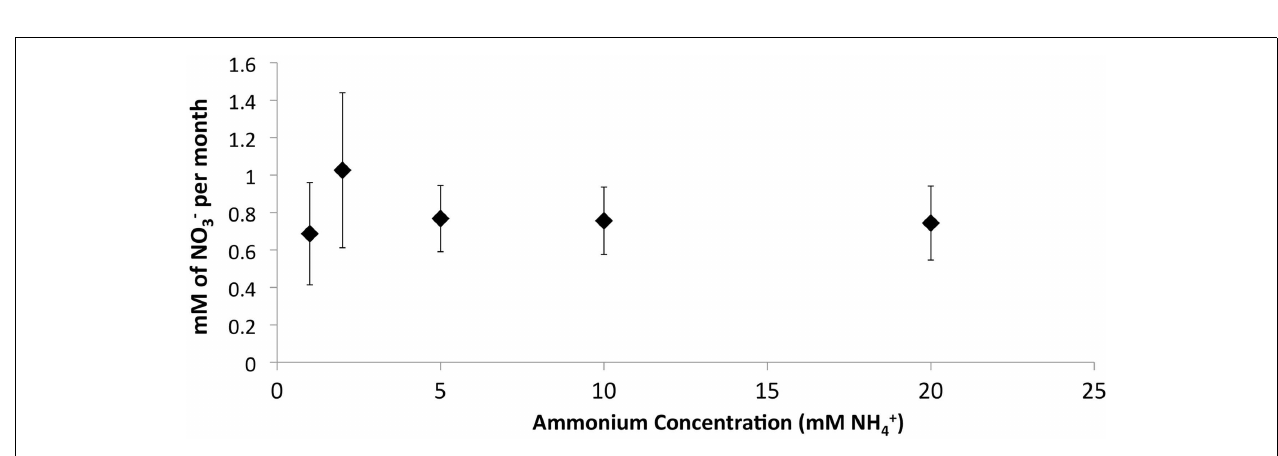
FIGURE 4 | Effect of increasing amounts of developed zeolite biofilm on PNA of retention pond samples collected from sites 1 and 3 (Figure 1) in January and May 2010. Samples were